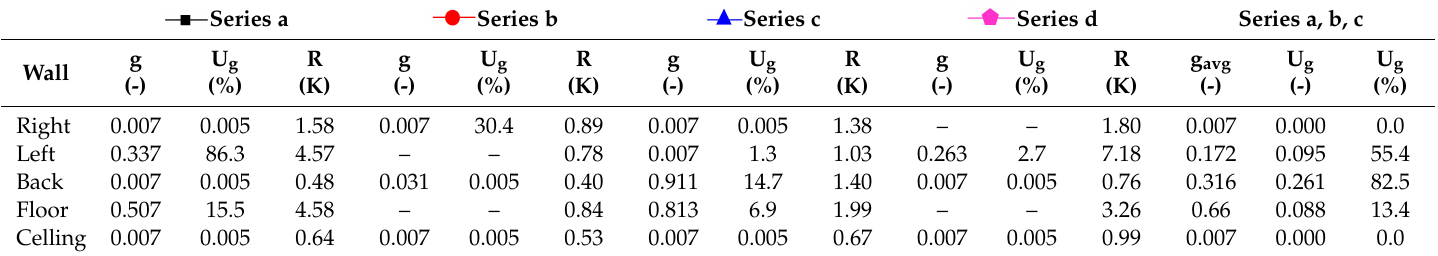
Table 8. Opaque walls. g value. Summary of the results using models that include solar radiation. Output: T i . Where e g is the error and R is the average of the residuals given by LORD for each data